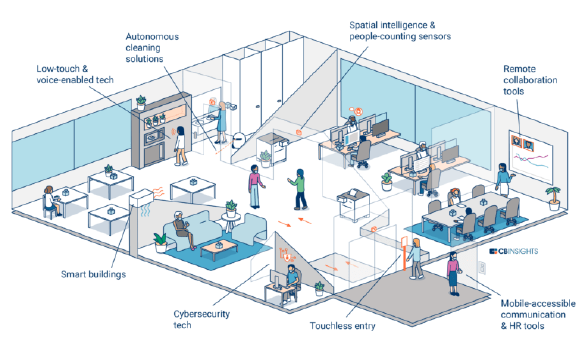
Figure1. IoT Applications to face